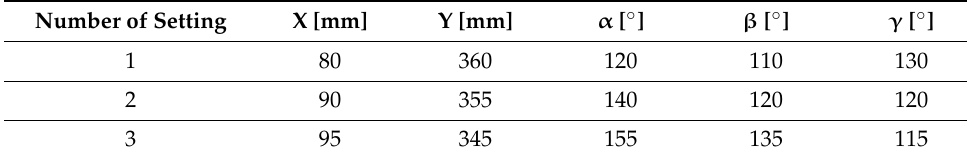
Figure 1. The model of the proposed flue gas tract: (I) X: width, (II) Y: height, (III) α , β , γ : angles. The first position of the first baffle used was 80 mm from the wall and an unchangeable height of 400 mm. At the end of the straight part of the baffle was a curvature which directs the flow of flue gases. The model settings were modified by changing the following parameters: (I) width X, (II) height Y, (III) angle α , (IV) angle β , and (V) angle γ . The values of changeable parameters are stated in Table 1. Table 1. The changeable parameters of the baffle.